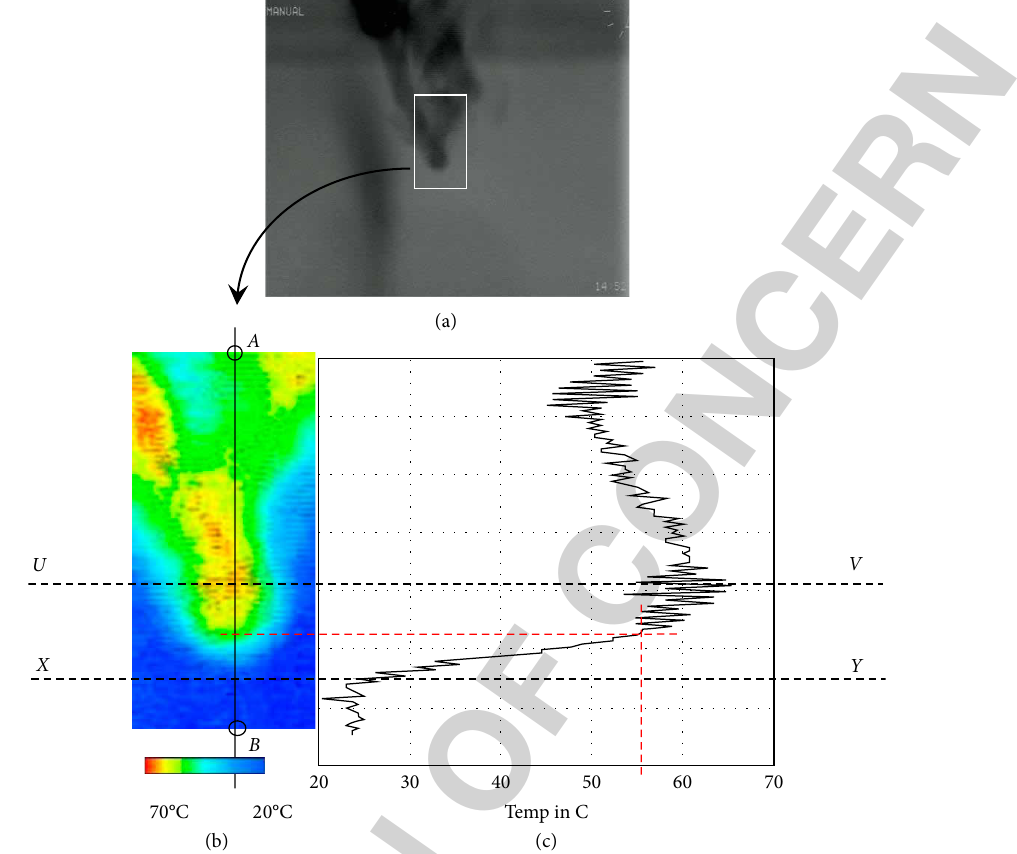
Figure 2: Figure extracted from reference [3]—Thermal image of the turnaround point (TAP) of the stream of the condensed steam droplets (CSD) and the vertical temperature distribution of the middle of TAP area. (a) Thermal image of downward projected CSD taken from the cryogenically cooled third generation forward looking infrared (FLIR) thermal camera (3–5 μ m). (b) Temperature distribution at the droplet turning around area. Color gradient is proportional to the temperature as shown in the plate below (c) temperature distribution along the line AB in (b). Reprinted from “Will rising water droplets change science?” by C. K. G. Piyadasa, 2011, Canadian Journal of Pure and Applied Sciences,